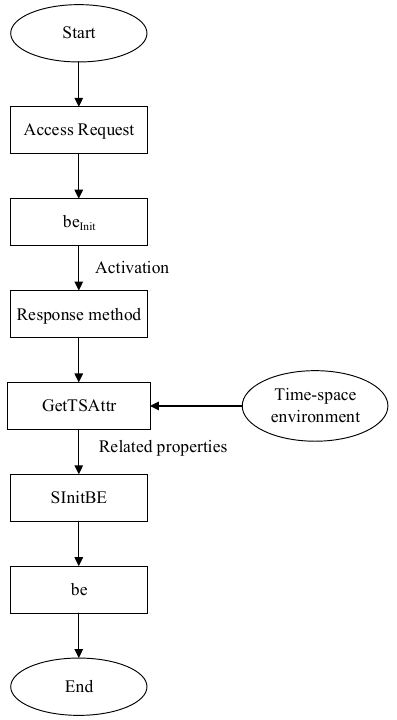
Figure 5. Secondary initialization flow chart. Algorithm 2: Secondary initialization algorithm